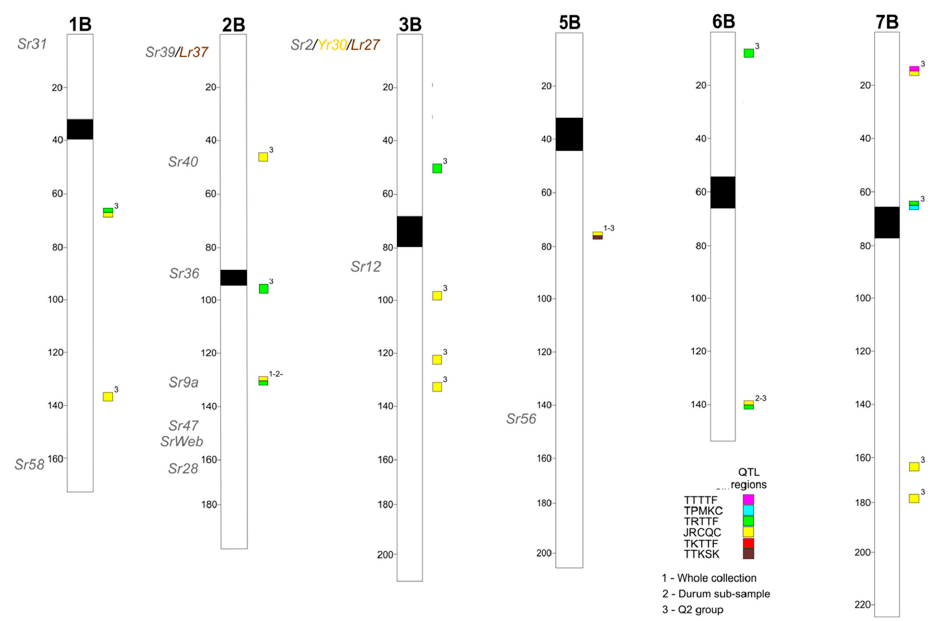
Figure 3. Schematic representation of a genome chromosomes of the durum consensus linkage map (Maccaferri et al. 2015) with map positions of QTLs for stem rust resistance. QTL regions were indicated on the right side and cM distances on the left side of the bar. QTLs are represented by squares on the right of each chromosome bar and a number related to a specific dataset, while the Sr genes on the left side.